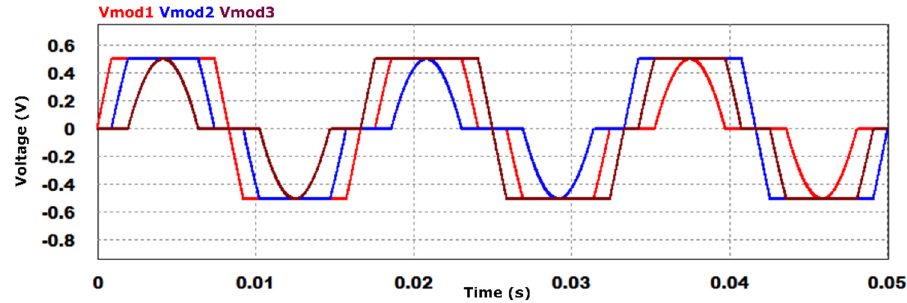
Figure 10. Modulating signals 1, 2, and 3.